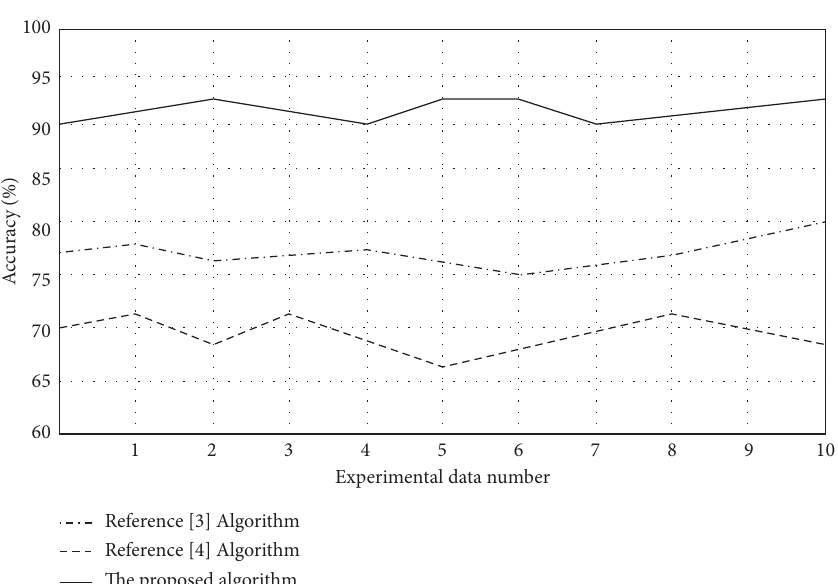
Figure 2: Accuracy rate of the spoken English pronunciation quality score.